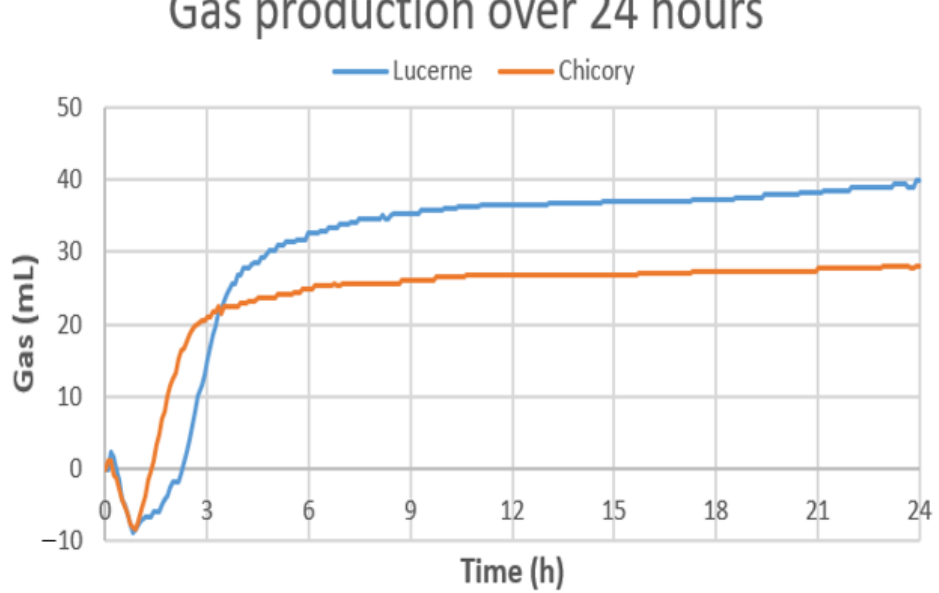
Figure 6. Gas production during cecal fermentation of chicory and lucerne.